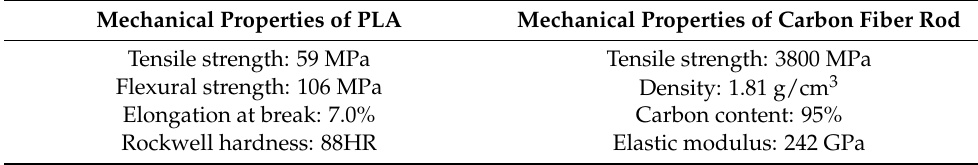
Table 1. Mechanical properties of polylactic acid (PLA) and carbon fiber rod.